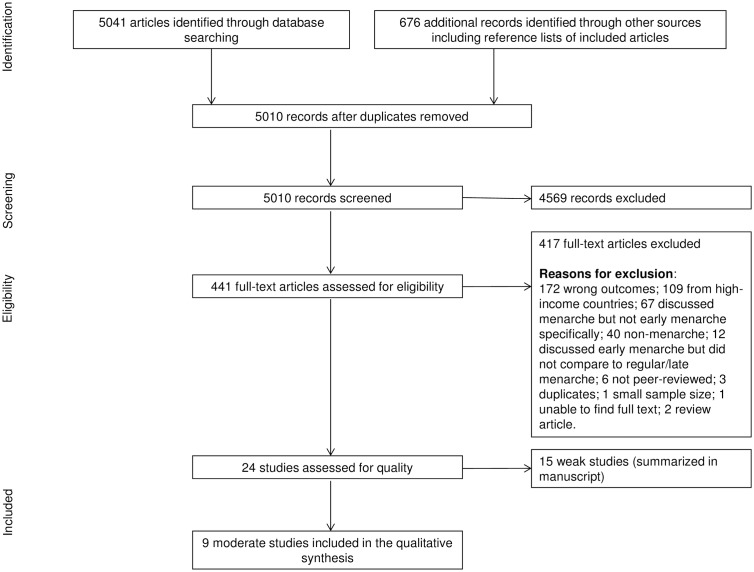
PRISMA flowchart of study selection for systematic review on early menarche and sexual and reproductive health in low- and middle-income countries.